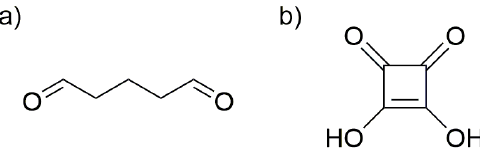
Figure 1. Structures of applied crosslinking agents ( a ) glutaraldehyde (Glu); ( b ) squaric acid (SqA).